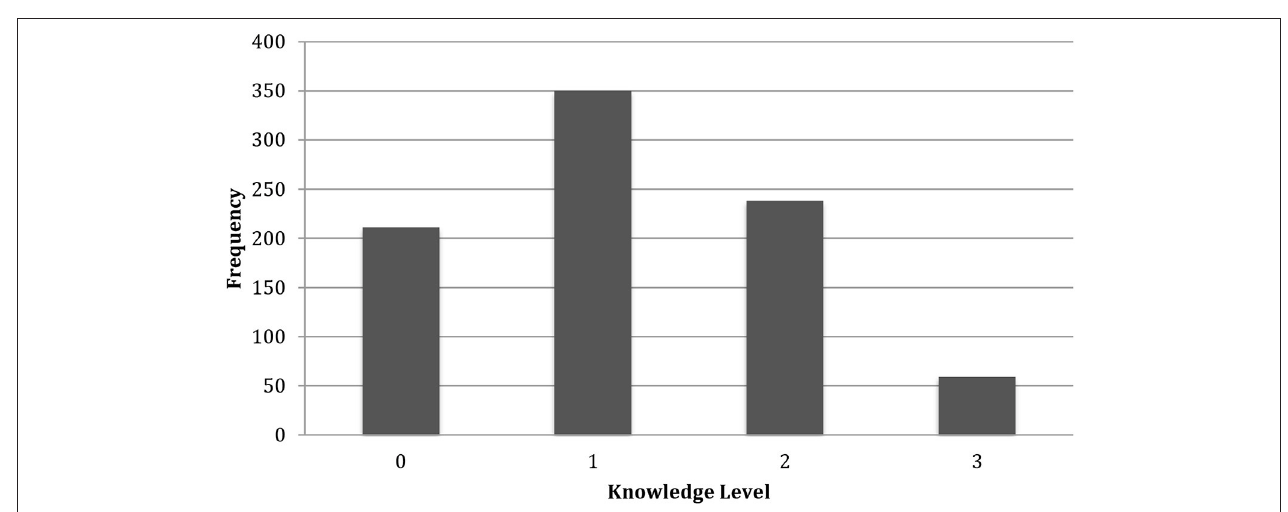
Percentage (%) of respondents Answers are represented as percentages (n =